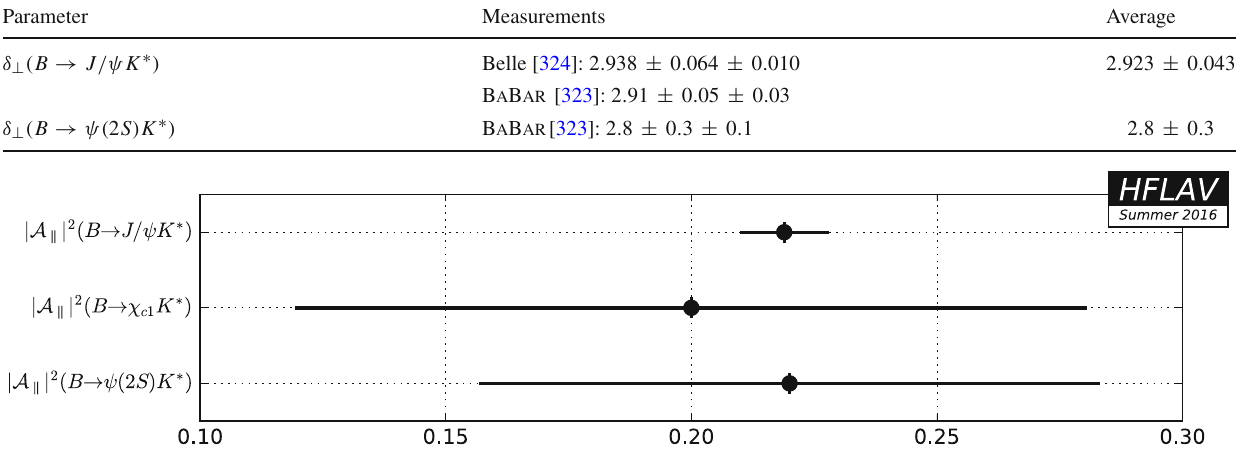
Table 184 Relative phases of perpendicular transverse polarization decay amplitudes